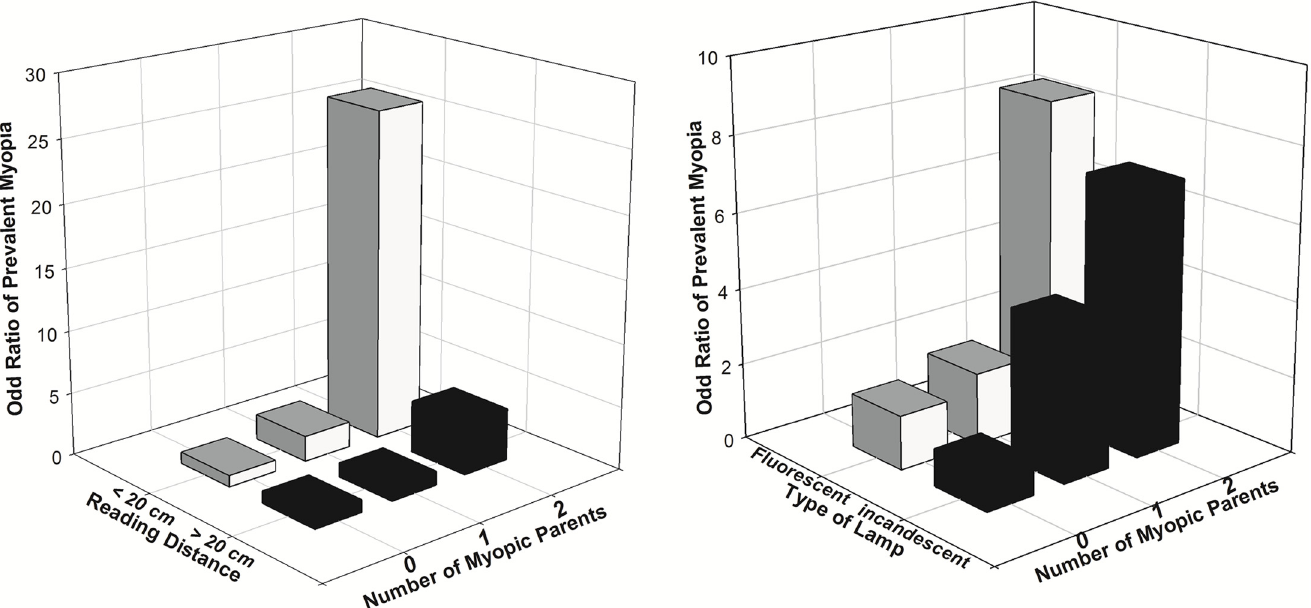
Fig 1. Multivariable-adjusted odds ratios (OR, adjusted for age, gender and height) for prevalent myopia by reading distance versus number of myopic parents (1A) and by type of desk light versus number of myopic parents (1B) in children. Reading distance was divided into (cid:1) 20 cm and > 20 cm. The children with reading distance > 20 cm and no myopic parents is the reference group (OR, 1). Type of desk light was divided into fluorescent and incandescent lamp. The children with desk light of incandescent lamp and no myopic parents is the reference group (OR,